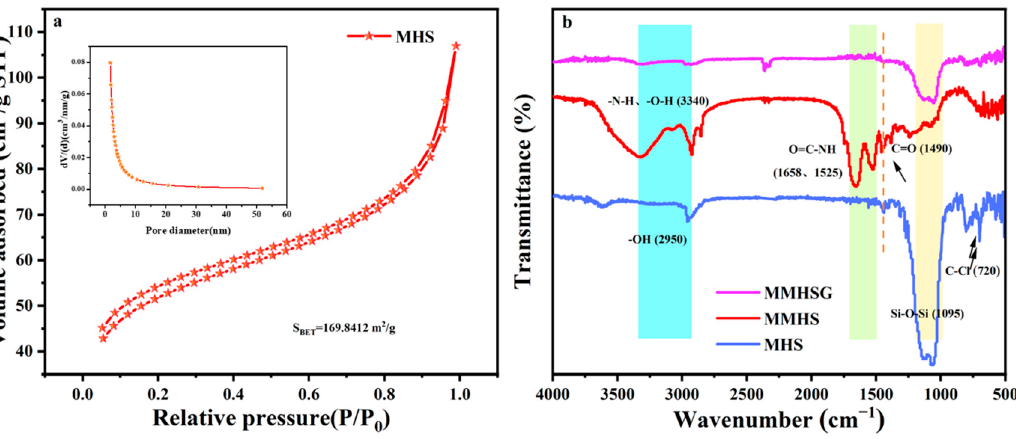
Figure 5. The N 2 adsorption and desorption isotherms (pore size distribution) of MHS ( a ) and FTIR spectra of MHS, MMHS and MMHSG ( b ).